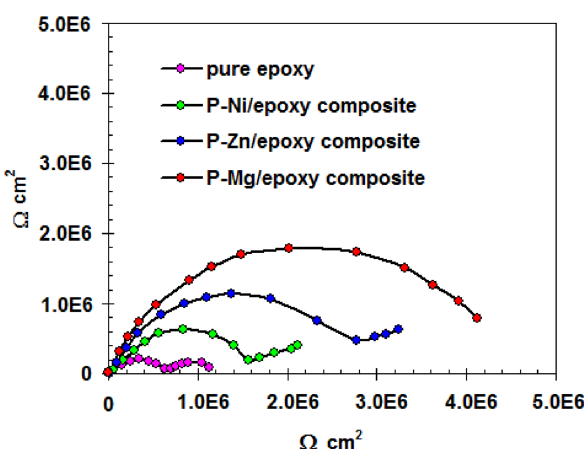
Figure 2. Nyquist plots for carbon steel electrodes coated with neat epoxy, P–Ni/epoxy nanocomposite, P–Zn/ epoxy nanocomposite and P–Mg/epoxy nanocomposite in 3.5% NaCl solution at 303